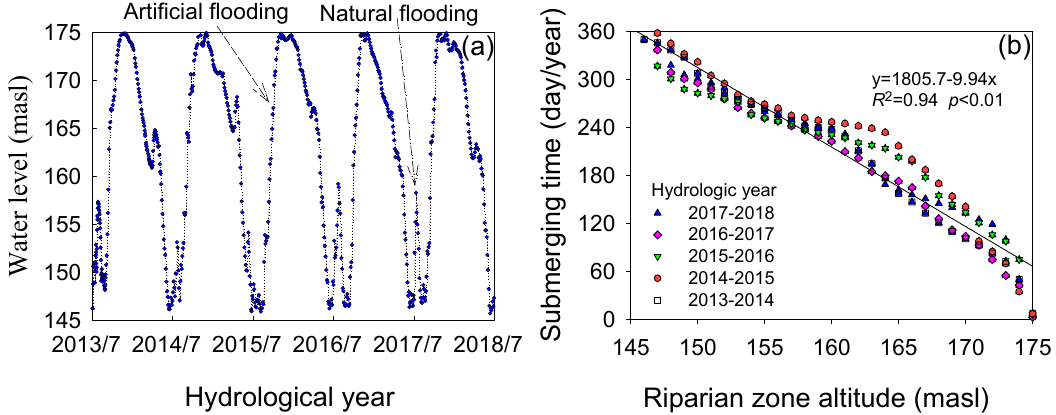
Figure 2. Water level fluctuation ( a ) and submerging time ( b ) from 2013 to 2018. The sampling was conducted in July 2017.